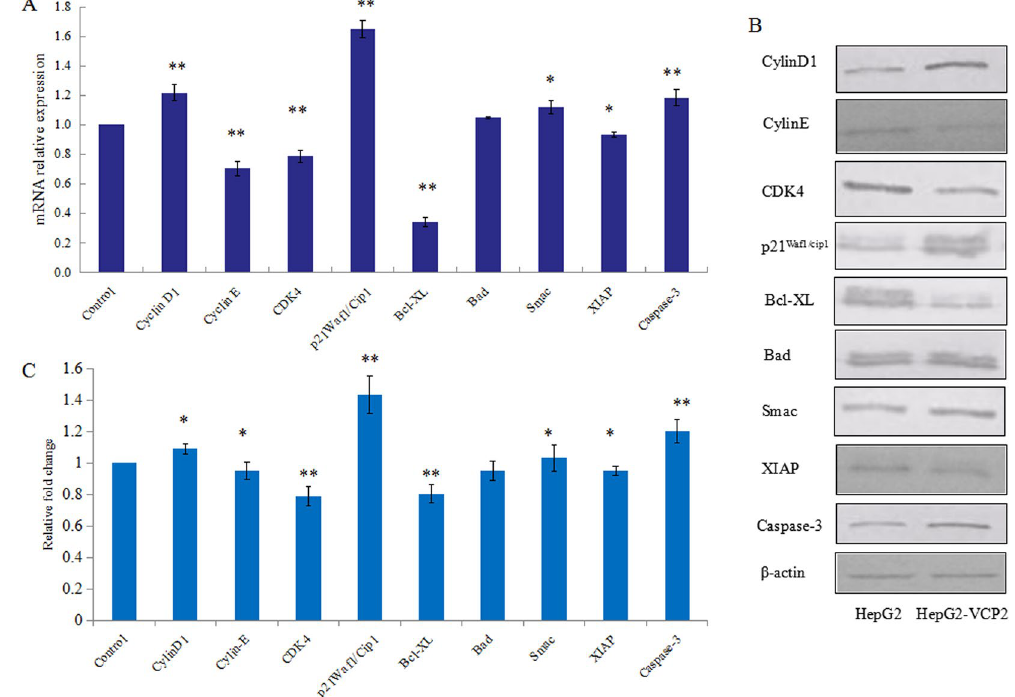
Figure 2. The expression of in HepG2 cells after polysaccharides treatment. ( A ) The mRNA expression in polysaccharides-treated HepG2 cells by qRT-PCR assay. ( B ) The protein expression in polysaccharides-treated HepG2 cells by WB assay. ( C ) Graphical representation of the average fold change in expression of the proteins between HepG2 cells and polysaccharides-treated HepG2 cells. Gene expression is normalized to β -actin expression. Values are means ± SD (n = 3), * p < 0.05, ** p < 0.01. The full-length gels and blots are included in Supplemental Fig.